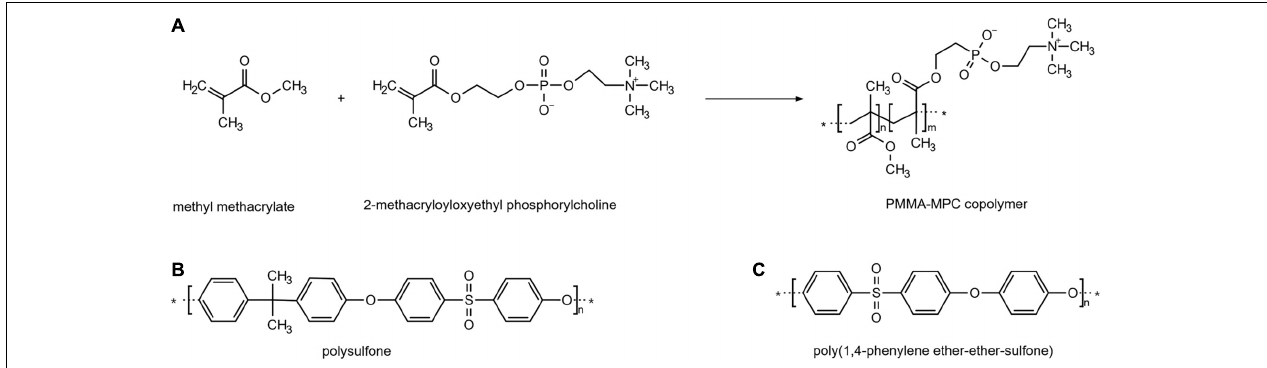
FIGURE 1 | Functionalization of the material. Chemical structures of the molecules for the modification of the liquid silicone rubber (LSR). The asterisk marks the point at which the monomers combine. They represent a repetition unit. (A) polymethylmethacrylat + 2-methacryloyloxyethyl phosphorylcholine (PMMA + MPC) (B) polysulfone (PSU) (C) poly(1,4-phenylene ether-ether-sulfone) (PPSP).